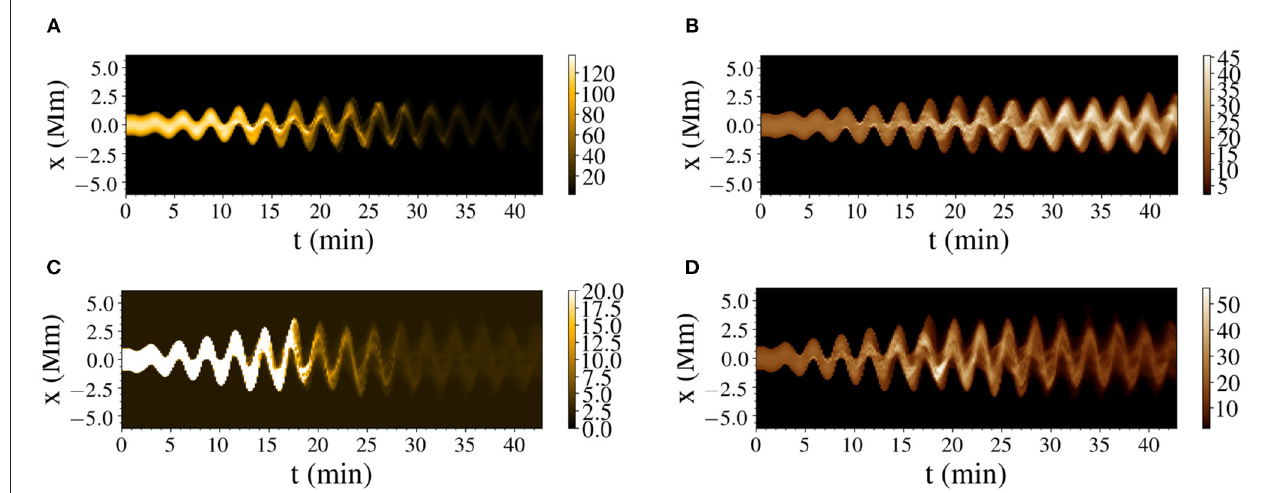
FIGURE 2 | Synthetic time-distance maps for the D2 model in the Fe IX 171 Å (A) and Fe XII 193 Å (B) and for the D4 model in the Fe IX 171 Å (C) and Fe XII 193 Å (D) lines at the apex. The time distance maps show the emission (in ergs cm − 2 s − 1 sr − 1 ) for the numerical resolution panels of our model. For the D4 model, the intensity in the 171 Åline is saturated, in order to clearly depict the drop in the emission. The LOS angle is 0 ◦ .